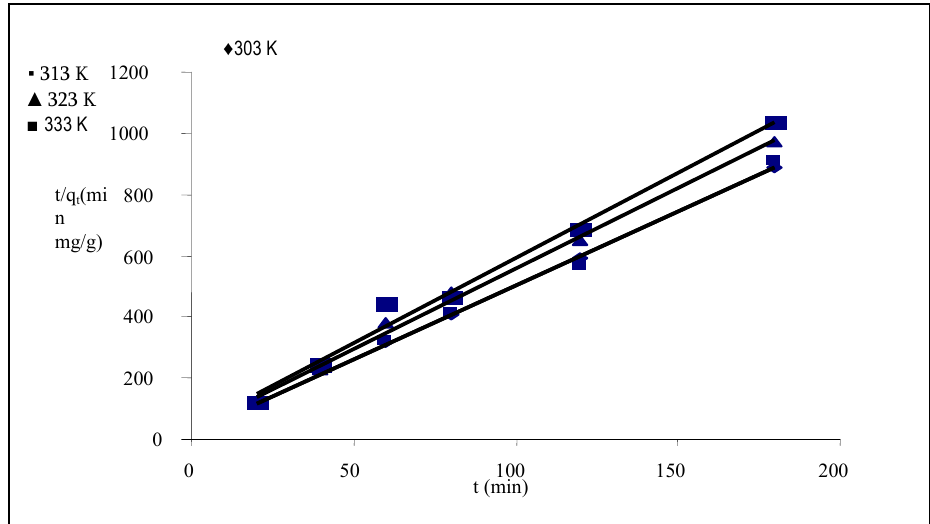
Figure 12. Pseudo-second-order kinetic plots for adsorption of fluoride onto eggshell powder at different temperatures (experimental conditions: Initial dye concentration: 5.0 mg/L, adsorbent dose: 2.4g/100ml, Particle size: 150µm agitation speed: 350 rpm, pH: 6.0, Temperature